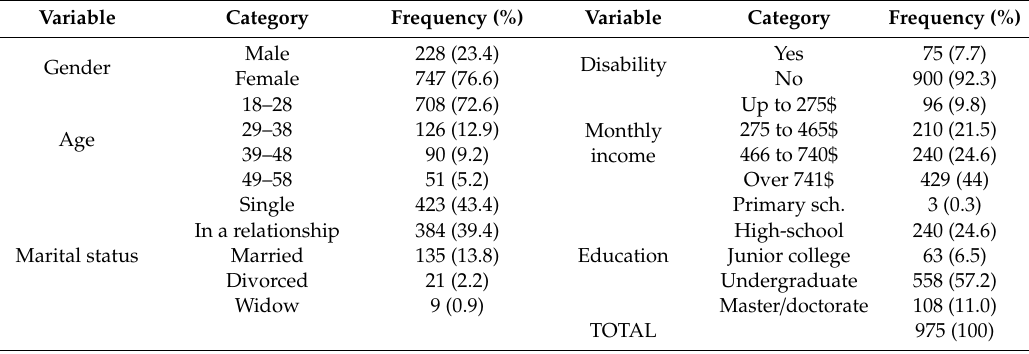
Table 1. Basic socio-economic and demographic information of respondents (n =